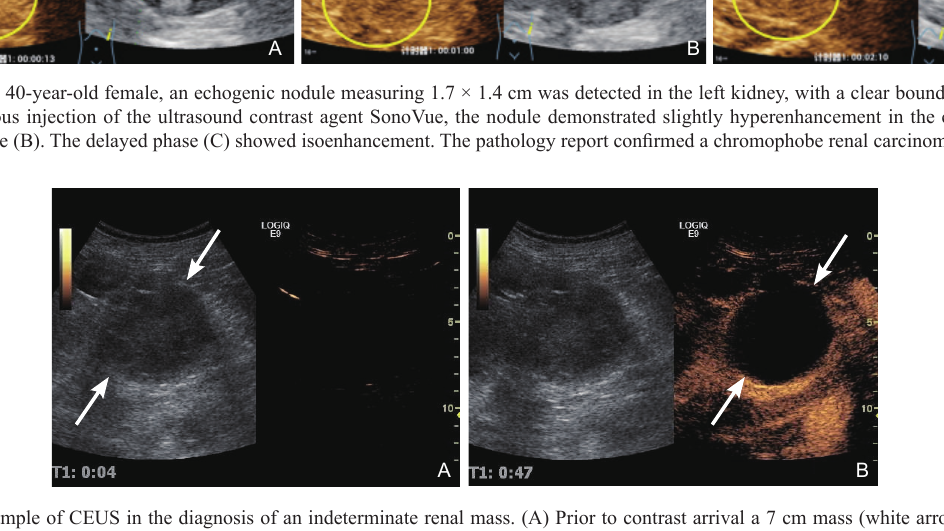
Figure 4 Example of CEUS in the diagnosis of an indeterminate renal mass. (A) Prior to contrast arrival a 7 cm mass (white arrows) is apparent in the right kidney with echoic components on B-mode suggesting solid components and possible malignancy. (B) Following arrival of the contrast agent (2 ml of Lumason, Bracco), no enhancement is observed within the suspected mass (white arrows), indicating it is a hemorrhagic cyst and ruling out RCC.